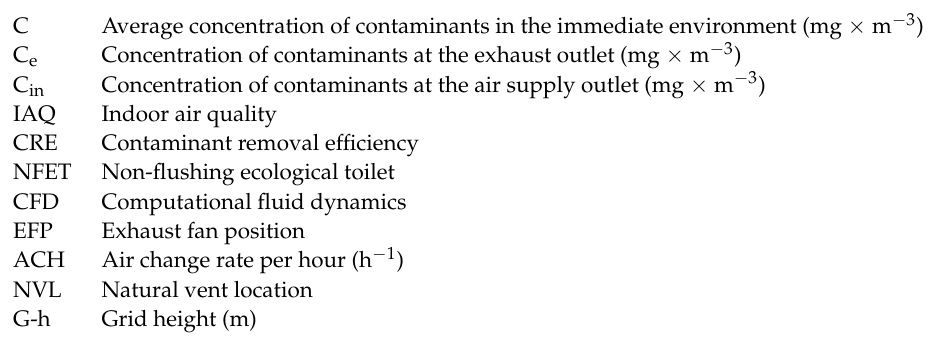
Figure S14. Ammonia diffusion dynamics for different positions of the exhaust fan (ACH = 3.6 h − 1